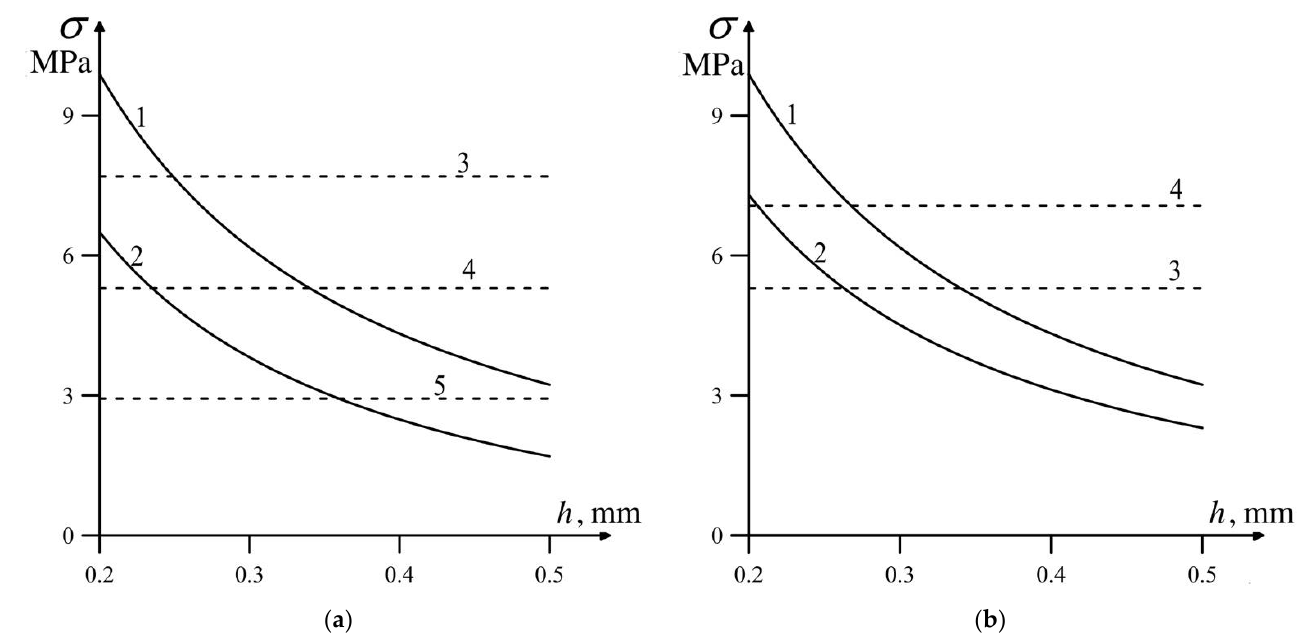
Figure 2. ( a ) Maximum tensile stresses in the ice crust at 𝑇 0 = −3 °C and external pressure 𝑝 0 = 0.5;1 MPa (solid lines 1 and 2), versus ice crust thickness. Dashed lines 3 – 5 show tensile strength 1 MPa (solid lines 1 and 2), versus ice crust thickness. Dashed lines 3–5 show tensile strength of ice of ice for different grain diameters: d = 10; 25; 100 µm. ( b ) Maximum tensile stresses in the ice crust for different grain diameters: d = 10; 25; 100 µ m. ( b ) Maximum tensile stresses in the ice crust at at 𝑝 0 = 0.5 MPa, and 𝑇 0 = −3 °C ; −10 °C (solid lines 1 and 2), versus ice crust thickness. Dashed p 0 = 0.5 MPa, and T 0 = − 3 ◦ C; − 10 ◦ C (solid lines 1 and 2), versus ice crust thickness. Dashed lines lines 3, 4 show tensile strength for grain diameter d = 25 µm. 3, 4 show tensile strength for grain diameter d = 25 µ